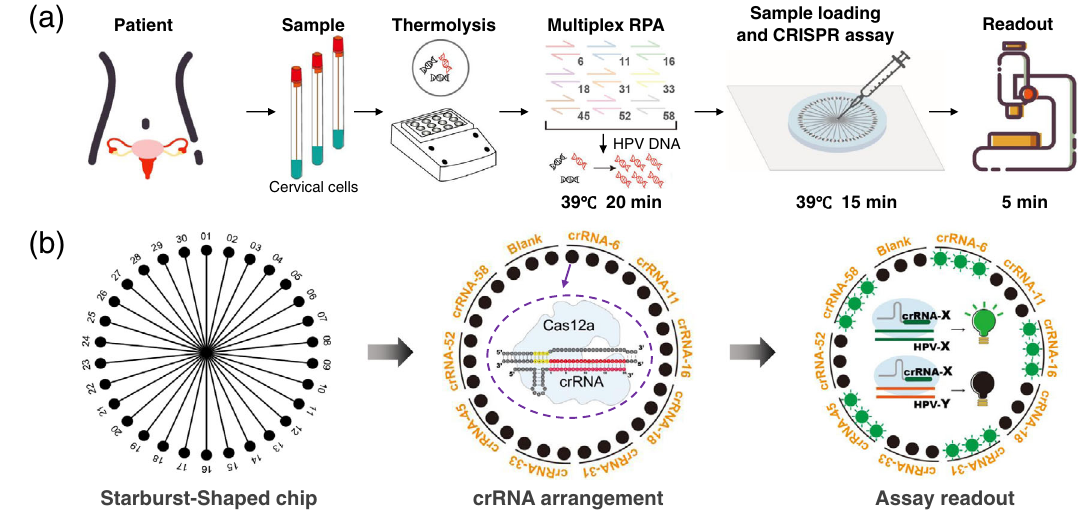
Fig. 1 | Scheme of the MiCaR-based HPV subtyping strategy. a Brief overview of the steps involved inthe subtyping process.The collected cervicalcell specimenis fi rst thermolyzed. Then, RPA is performed to amplify the nine HPV subtypes. The amplicons are subsequently tested via the CRISPR-Cas12a system on the micro- fl uidic device, followed by fl uorescence imaging to obtain the readout. b On-chip